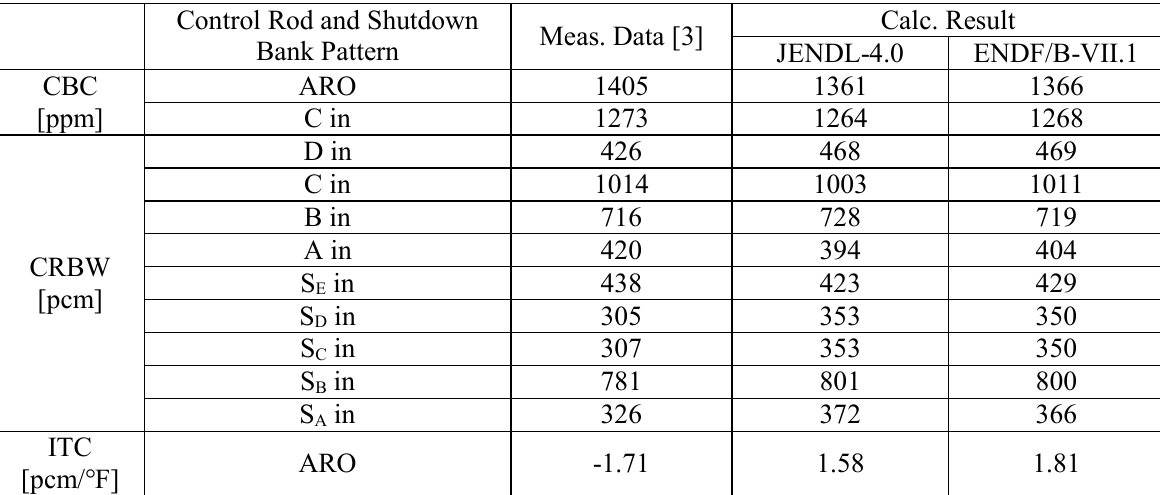
Table III. HZP Physics Test Results of Cycle